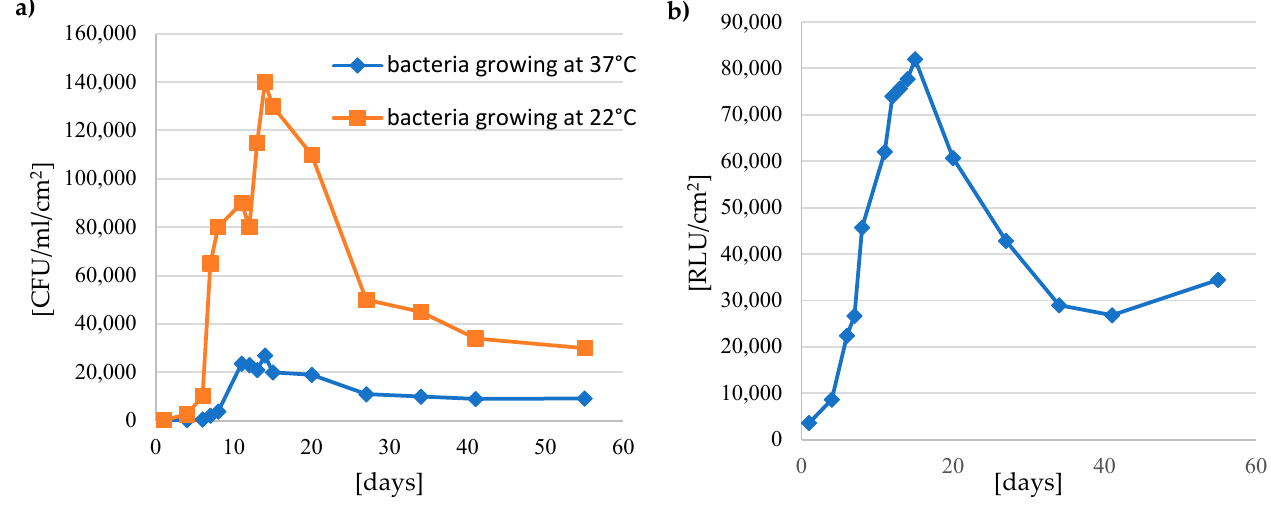
Figure 2. Microbiological analysis of biofilm taken from plates: ( a ) HPC method (R2A agar), ( b ) ATP analysis. Table 2. Pearson’s correlation coefficient between the examined microbiological parameters.